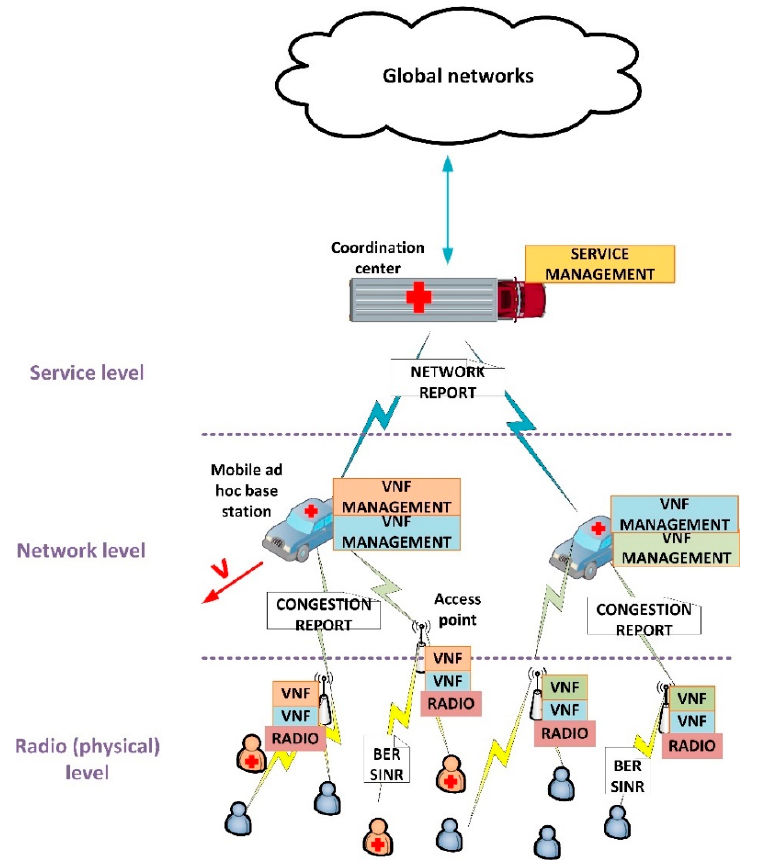
Figure 1. Global overview of the proposed solution.